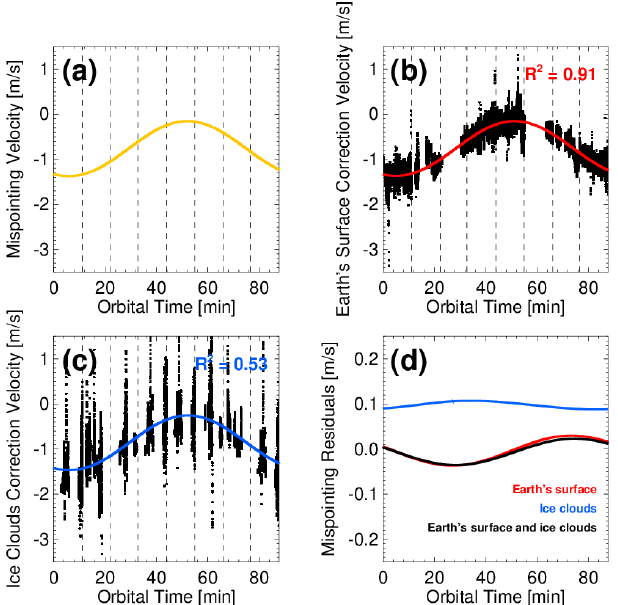
Figure 8. (a) Mispointing velocity introduced in the test data, (b) Earth’s surface correction, (c) ice cloud correction and (d) mis- pointing velocity residuals of the Earth’s surface, ice clouds and combination of the Earth’s surface and ice cloud correction together (for comparative purposes). The red, blue and black solid lines rep- resent the regression